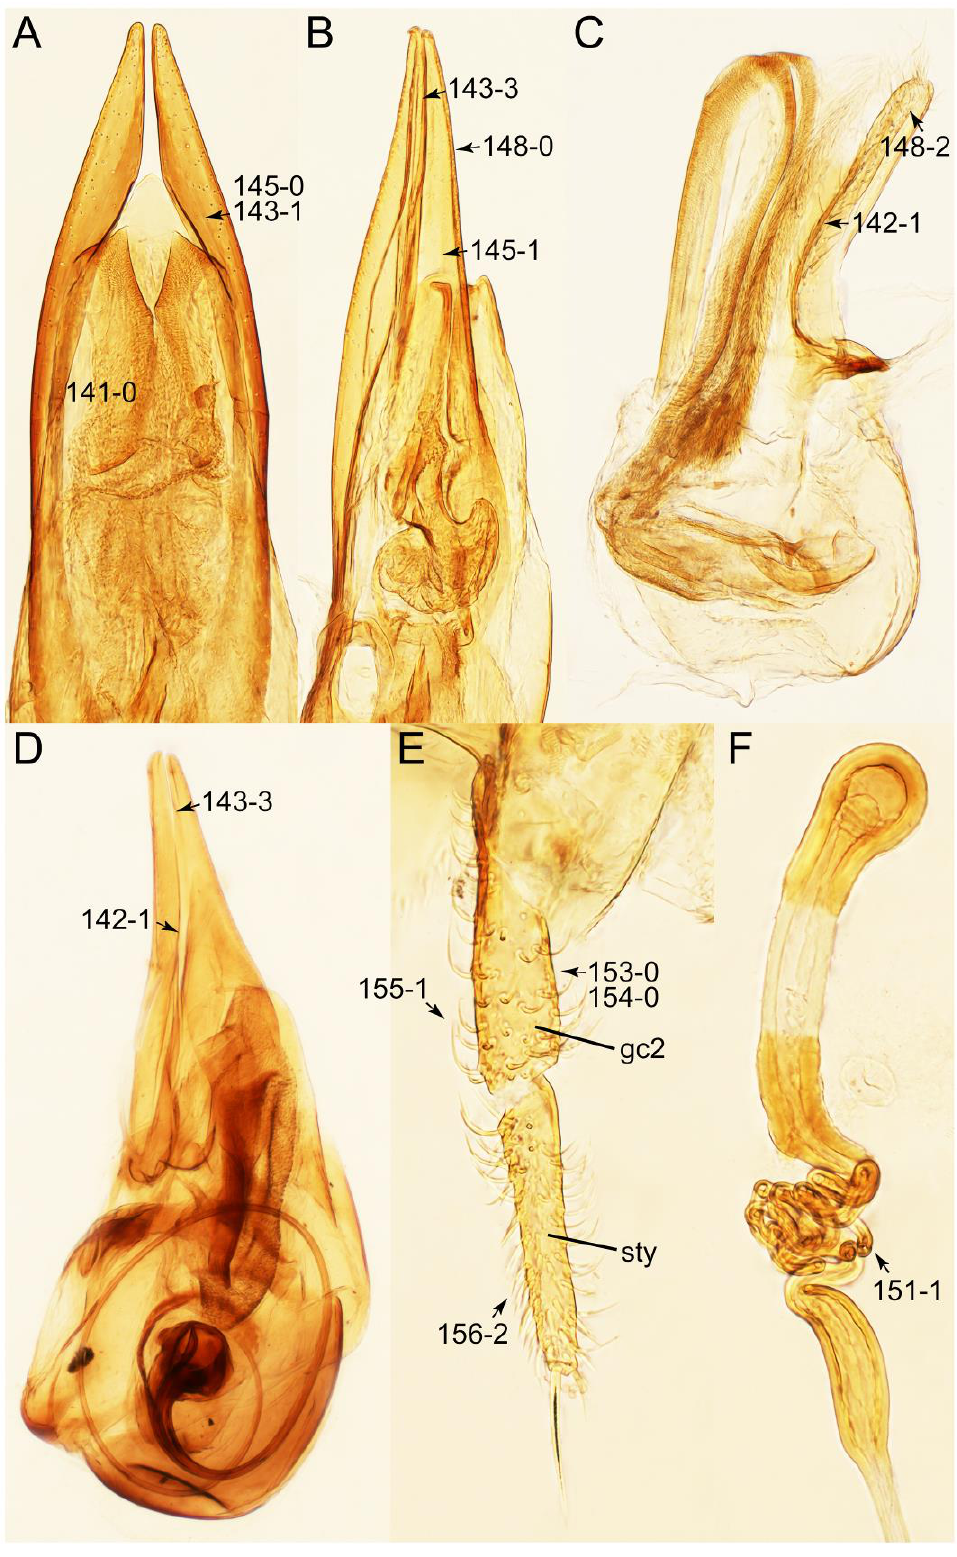
Figure 56. Photographs of body parts of Tachinusini, enlarged. ( A ) male aedeagus of Leucotachinus luteonitens , ventral view. ( B ) male aedeagus of Nitidotachinus tachyporoides , ventrolateral view. ( C ) male aedeagus of Tachinomorphus grossulus , lateral view. ( D ) male aedeagus of Olophrinus cf. philippinus , lateral view. ( E ) female gonocoxites and gonostylus of Tachinus frigidus Erichson, dorsal view. ( F ) female spermatheca of Tachinus frigidus . Characters and character states (format X-X) are indicated on each